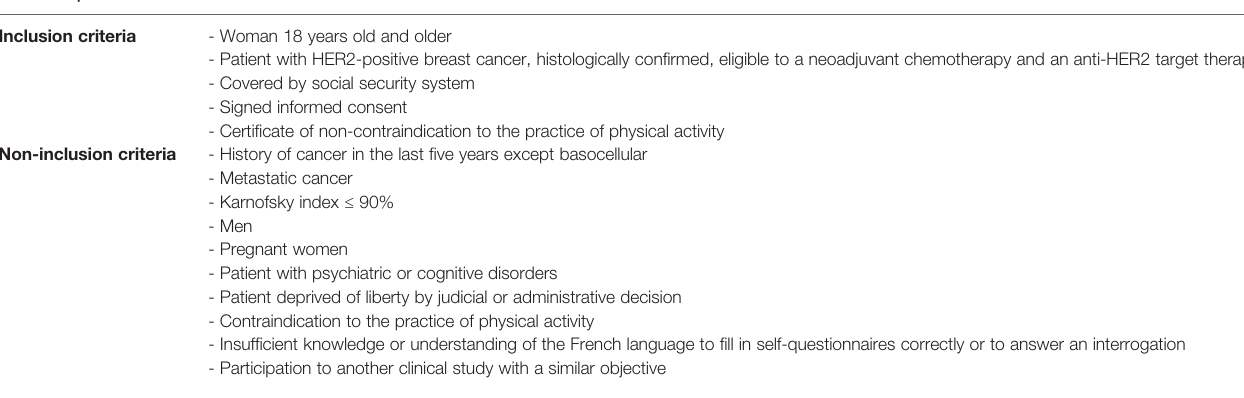
TABLE 2 | Selection